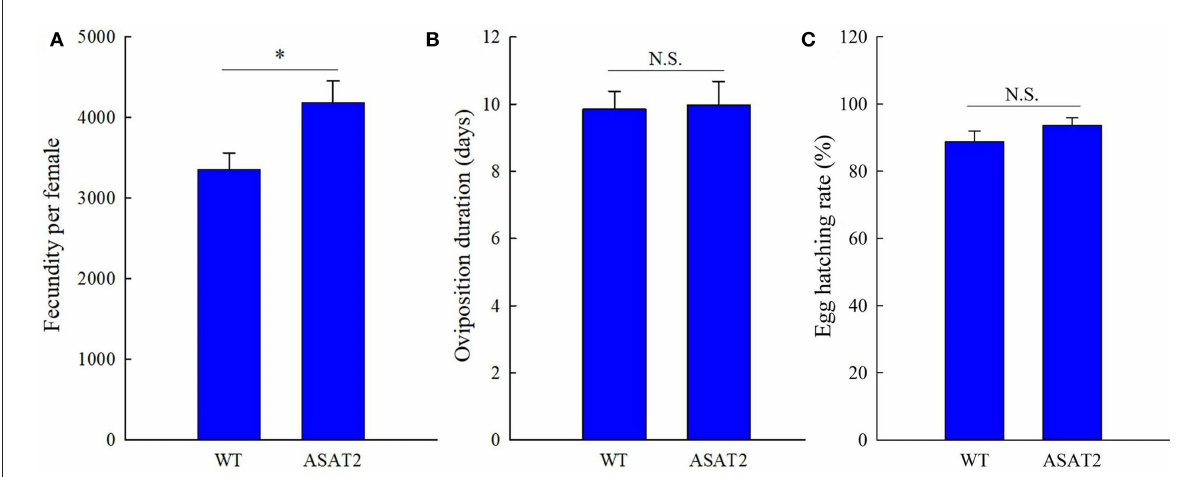
FIGURE6 Fecundity (A) , oviposition duration (B) , and egg hatching rate (C) of the F 1 generation of S. litura on WT and ASAT2 plants of N. benthamiana . Values are presented as means ± SE. Asterisks above error bars indicate significant differences ( P < 0.05), and n.s. indicates not significant ( P > 0.05).